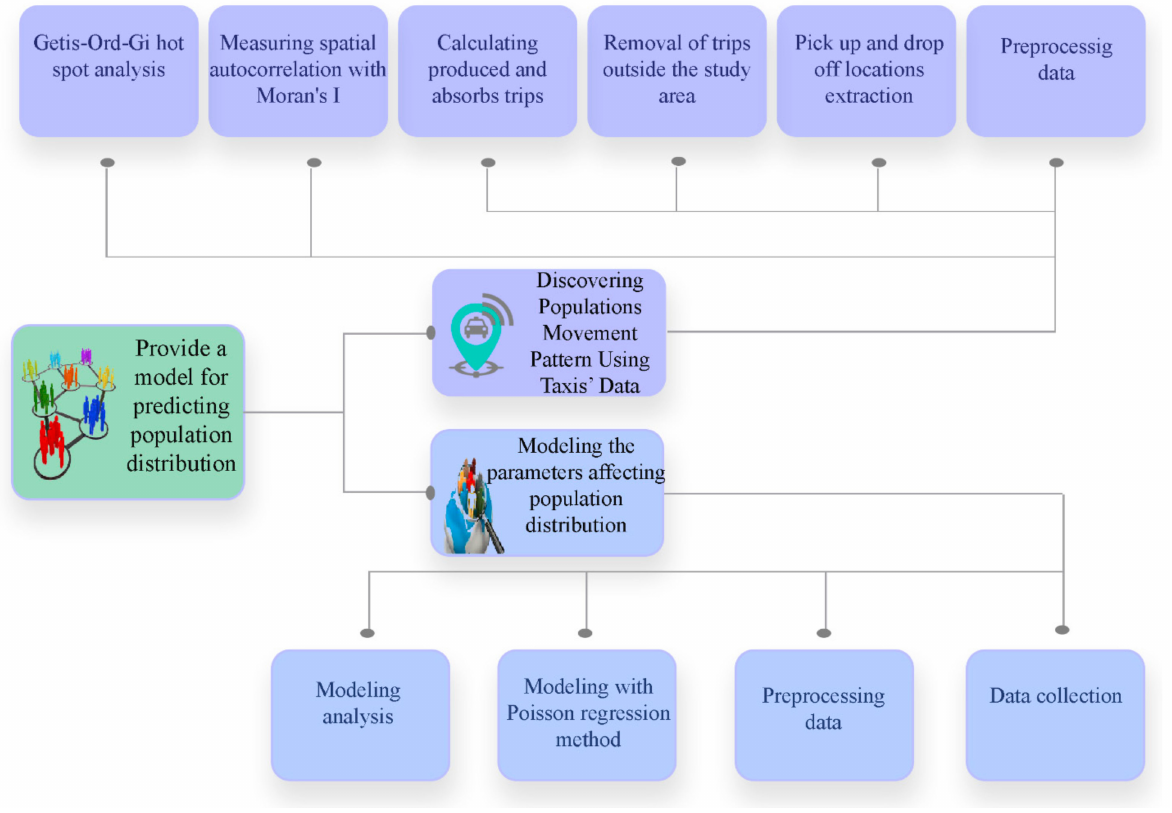
Figure 2. The stages of